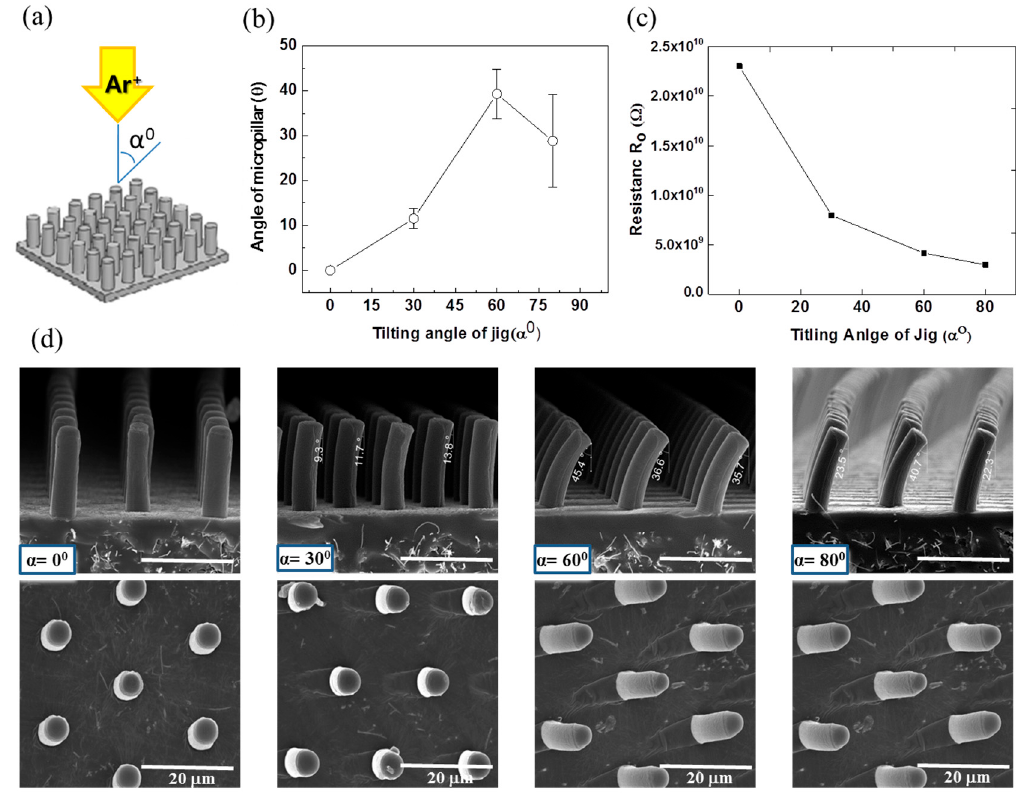
Figure 4. ( a ) Schematic of Ar + ion beam irradiation with different incident angles; ( b ) the angles of curved micropillars according to the incident angles of ion beam irradiation; ( c ) initial resistances of the curved micropillar structured MWCNT/PDMS films according to the incident angles of ion beam irradiation; ( d ) FESEM images of the micropillars according to the incident angles of ion beam irradiation at 0°, 30°, 60° and 80° in side view (upper images) and top view (bottom images). Table 1. Initial resistance (R o ) of planar PDMS-MWCNT film before and after Ar + ion beam treatment. Planar PDMS-MWCNT Film